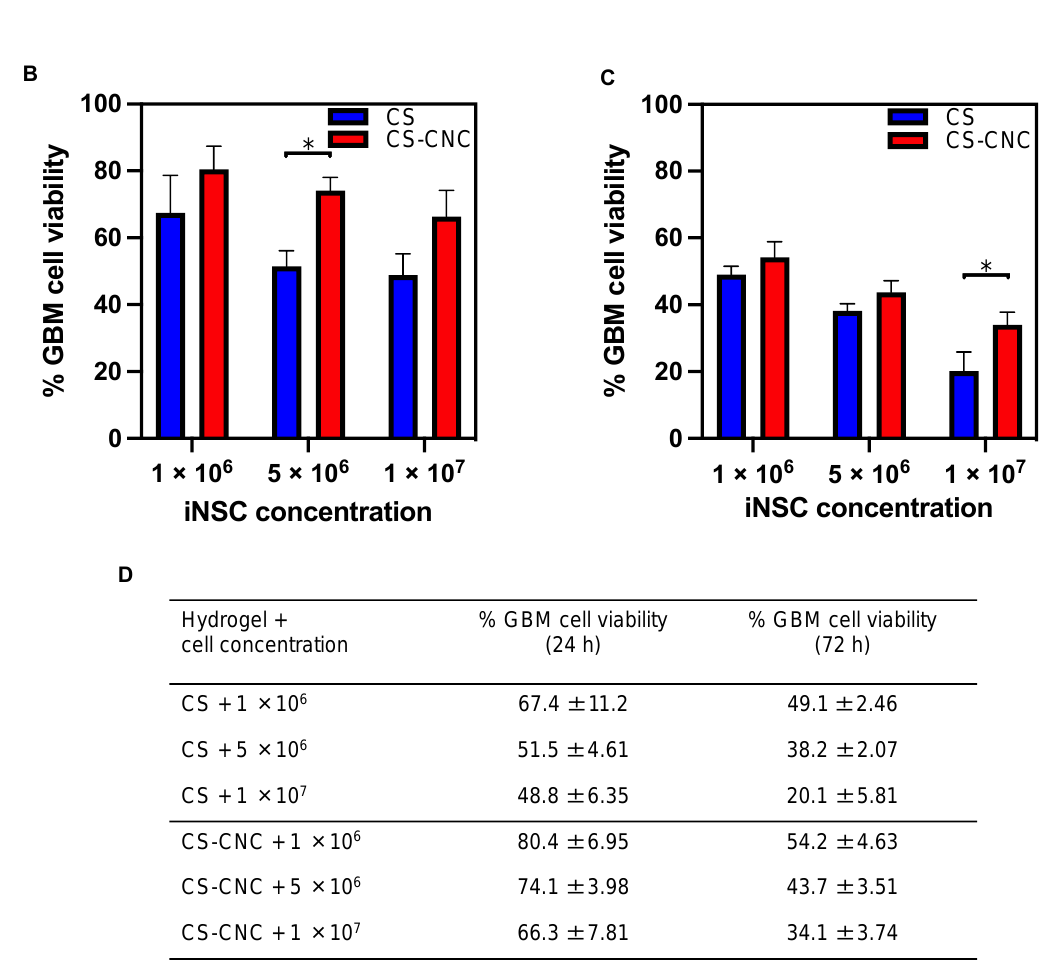
Figure 8. In vitro cell killing activity of NSC-laden CS and CS-CNC hydrogels. ( A ) Schematic illustration of in vitro cytotoxicity experimental design. ( B ) Percent GBM cell viability post 24-h culturing with iNSC-hydrogels relative to non-treated control ( n = 6, 100 µ L samples; * indicates p < 0.05). ( C ) Percent GBM cell viability post 72-h culturing with iNSC-hydrogels relative to non- treated control ( n = 6, 100 µ L samples; * indicates p < 0.05). ( D ) Summary table %GBM cell viability in NSC-laden hydrogel